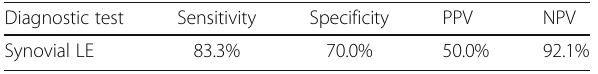
Table 3 The efficiency of synovial LE test compared with the results of synovial WBC count Diagnostic